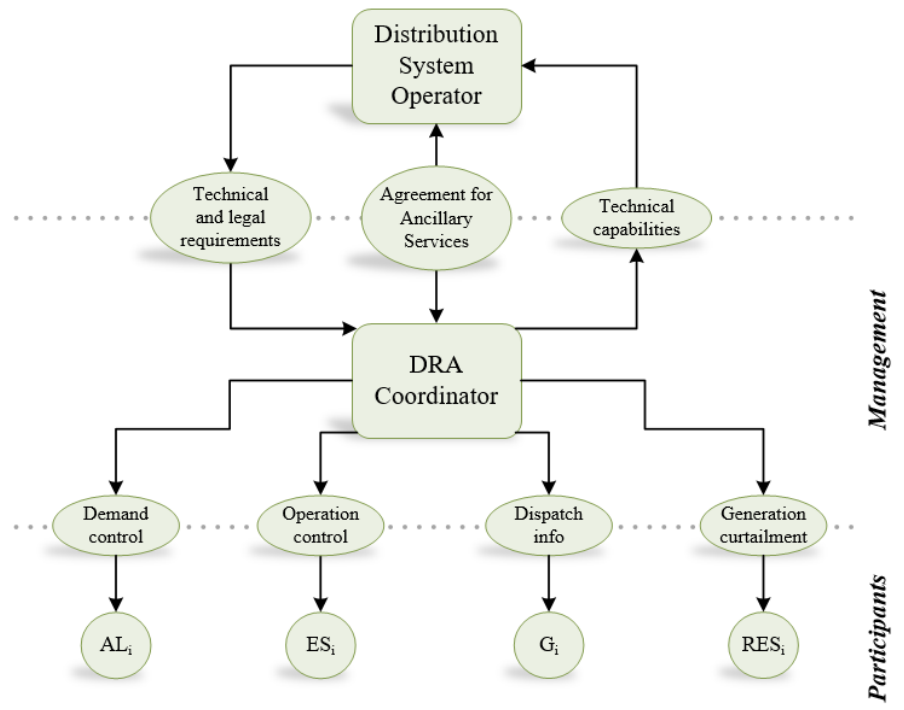
Figure 4. The proposed structure of the distributed resource aggregator (DRA) and its cooperation with other entities.